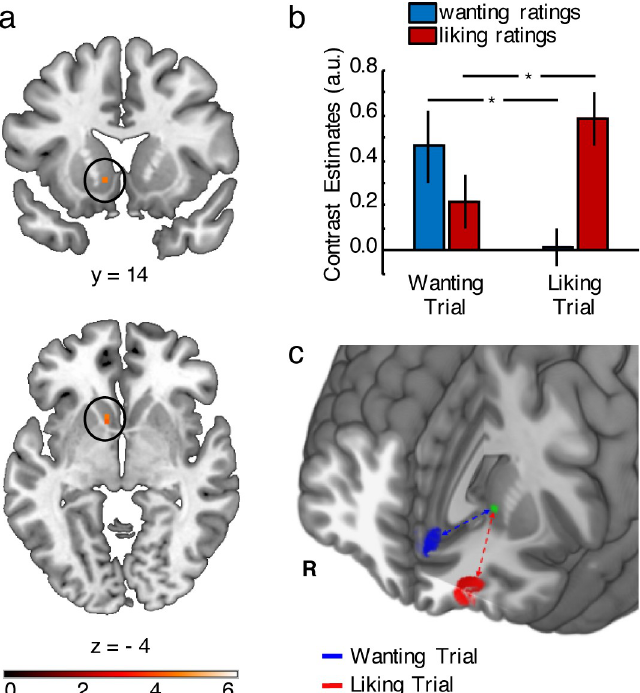
Fig 3. Potential gating of behaviorally relevant reward dimensions by frontostriatal connectivity. A–B . Behaviorally relevant encoding of wanting or liking levels in the VS. A. Conjunction of the PMs for wanting and liking. B. Activity in the VS encoded wanting ratings during wanting trials and liking ratings during liking trials. C. Functional connectivity between VS and prefrontal activations related to current wanting and liking levels depended on whether participants were making wanting or liking judgments. � p < 0.05; error bars depict SEM. Data in S1 Data. R, right; SEM, standard error of the mean; VS, ventral